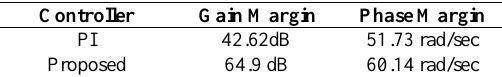
Table III. Frequency domain Parameters